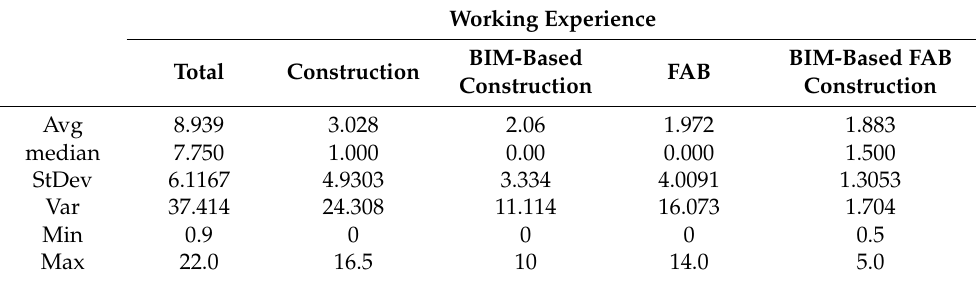
Table 5. Descriptive statistics: the owner group (N = 18).